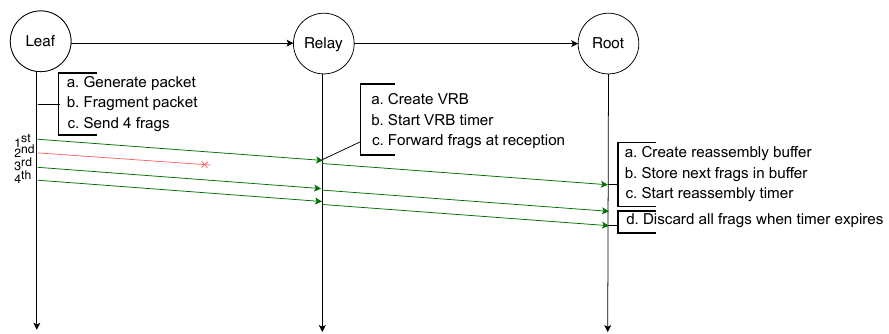
Figure 8. Unsuccessful transmission of a fragmented packet over two hops with MFF: the loss of the second fragment is not